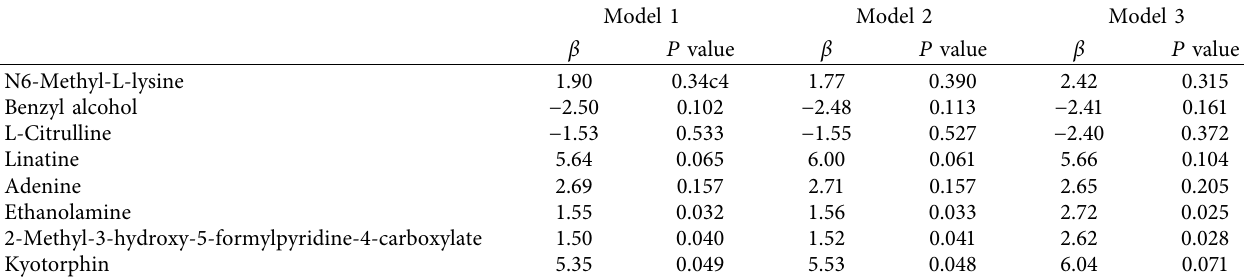
Table 2: Selected metabolites (VIP > 1 and adjusted q value < 0.05) according to logistic regression